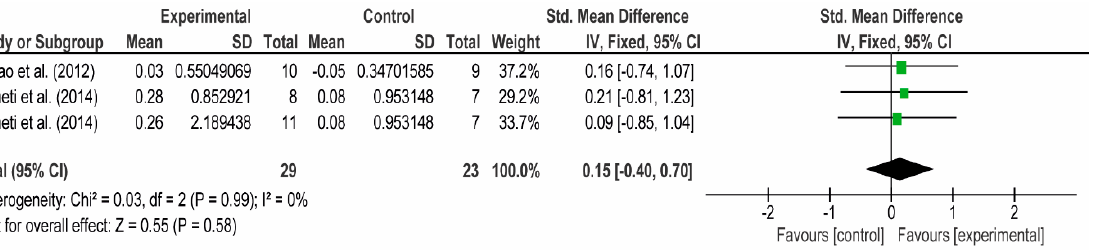
Figure 9. The effect size of low-intensity bench press training with blood-flow restriction on the triceps brachii CSA.